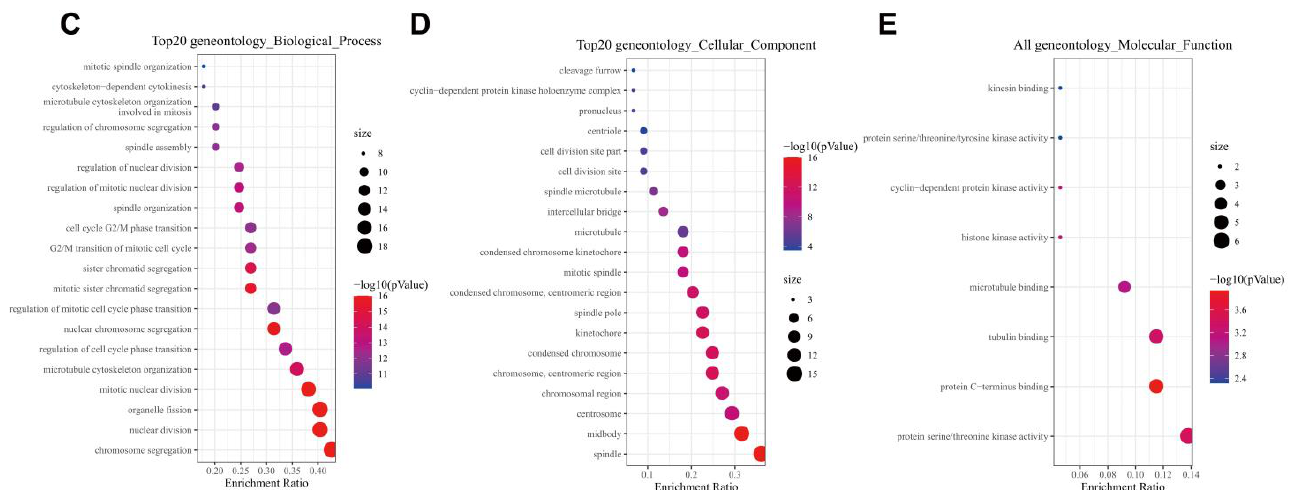
Figure 4. Functional enrichment analysis of the key genes. ( A ): Venn diagram of tumor stem cell- related marker genes, order gene and module genes; ( B ): KEGG enrichment analysis of the 45 key genes. The color indicates the pathway categories and the circle size represents the number of targets enriched; ( C ): A bubble diagram of the GO-BP analysis results of the 45 key genes; ( D ): A bubble diagram of the GO-CC analysis results of the 45 key genes; ( E ): A bubble diagram of GO-MF analysis results of the 45 key genes. In panels ( C – E ), the circle color indicates the p value, the circle size represents the number of targets enriched, and the abscissa represents the proportion of enriched targets and the ordinate indicates the pathway.